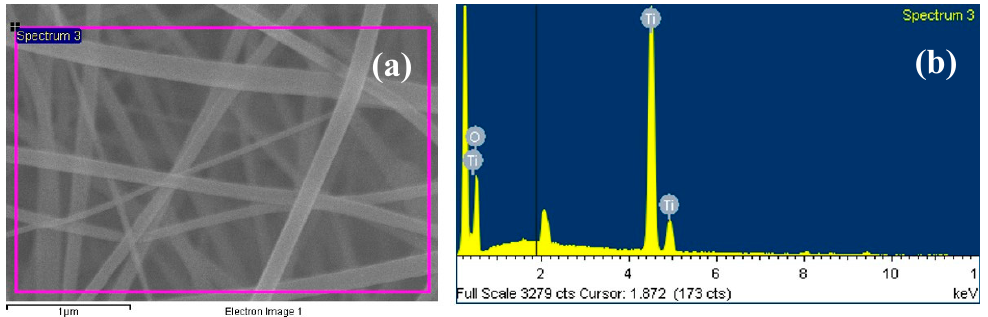
Figure 5. EDX results for PAN/TIIP nanofiber mat befor calcination ( a ) picked position; ( b ) elementary analysis.